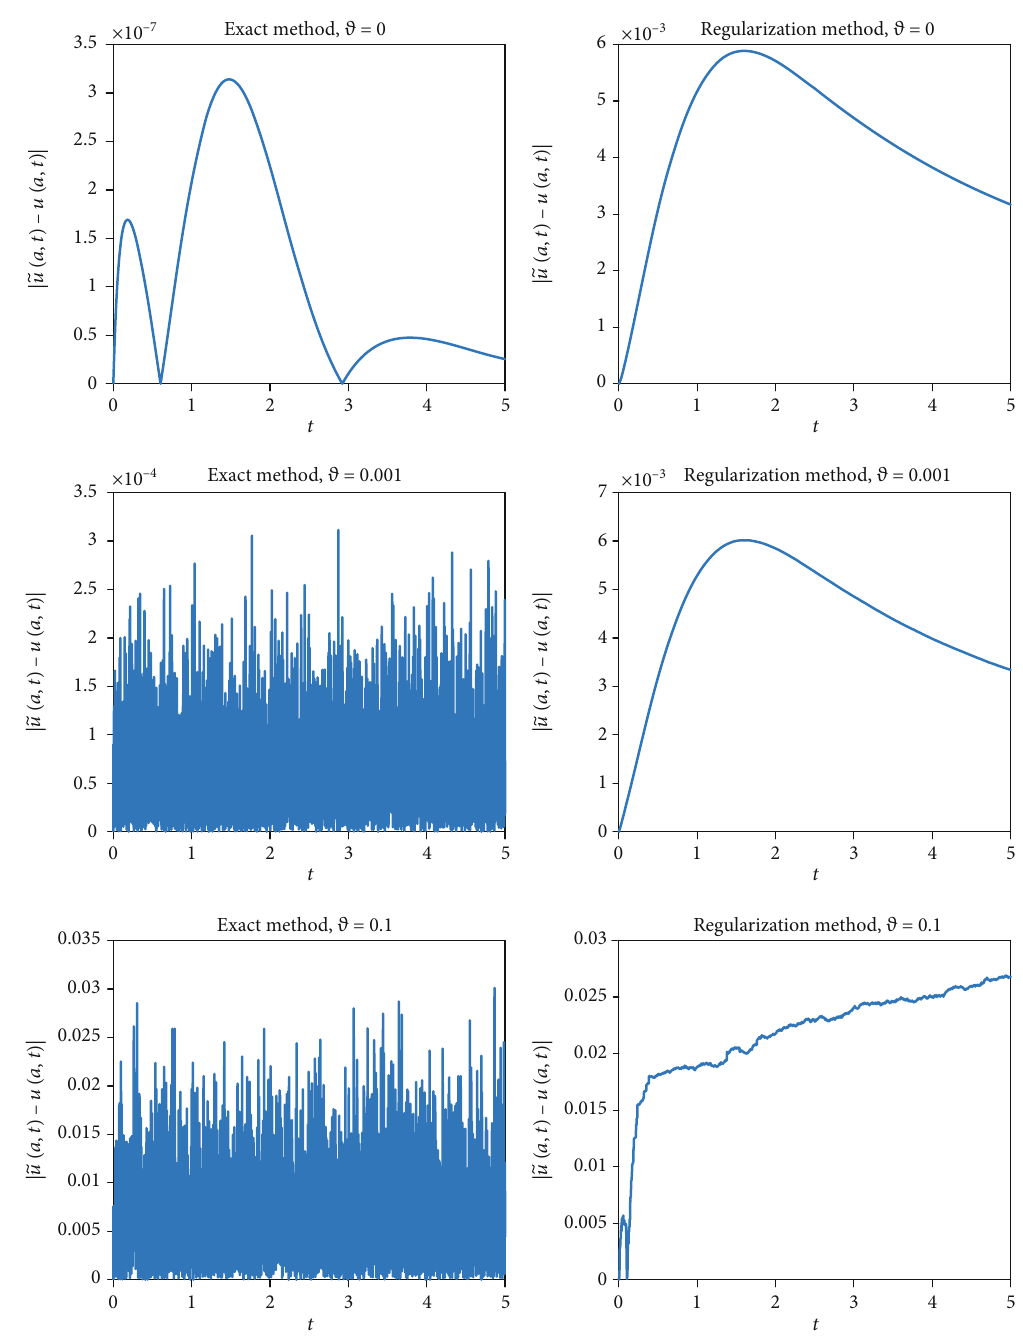
Figure 2: The absolute errors j ~ u ð a , t Þ − u ð a , t Þj , with the exact and regularization methods and di ff erent values of noises for Example 1 using Δ t = 0 : 001 and h = 0 : 05